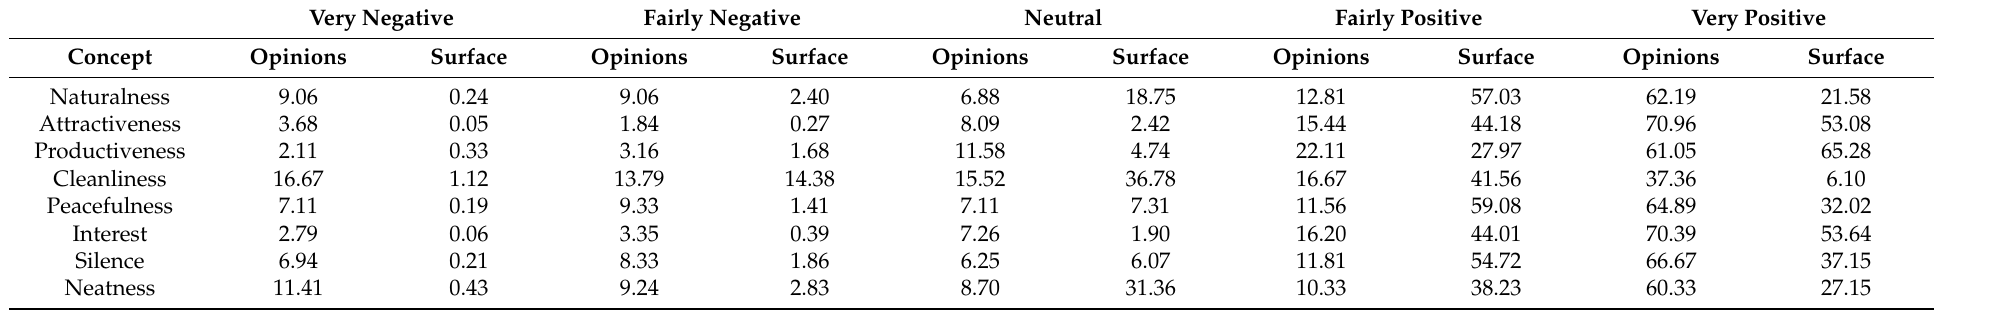
Table 5. Percentage of opinions and interpolated surface by concept and